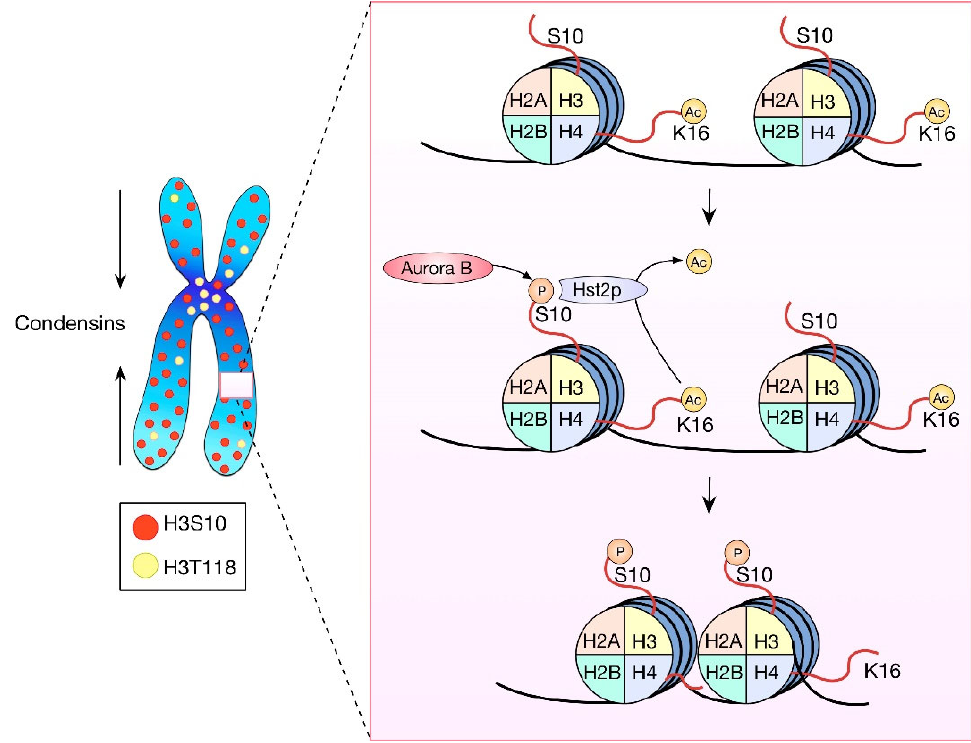
Figure 1. HPTMs in chromosome condensation. Condensins participate in the axial shortening of chromosomes while histone modifications allow the local compaction. H3 is phosphorylated in the serine 10 along all the chromosomes. This modification recruits Hst2p, which deacetylates H4K16 by inducing local nucleosome joining and local chromatin compaction. H3T118 also participates in chromosome condensation, and its distribution is preferentially in the pericentromeric chromatin, but its function is still unknown.